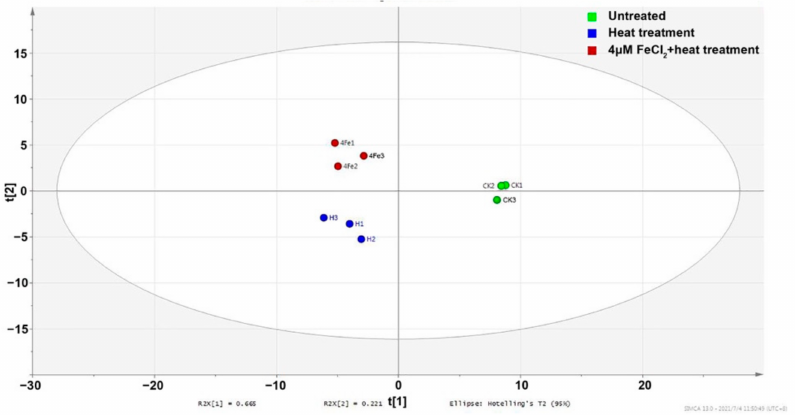
Figure 4. PCA score plot based on volatiles in tea infusions with different